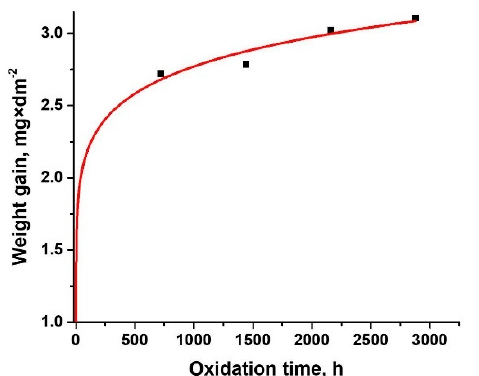
Figure 2. Oxidation kinetics of CrN x -coated 310 H SS samples after different periods of oxidation in supercritical water.